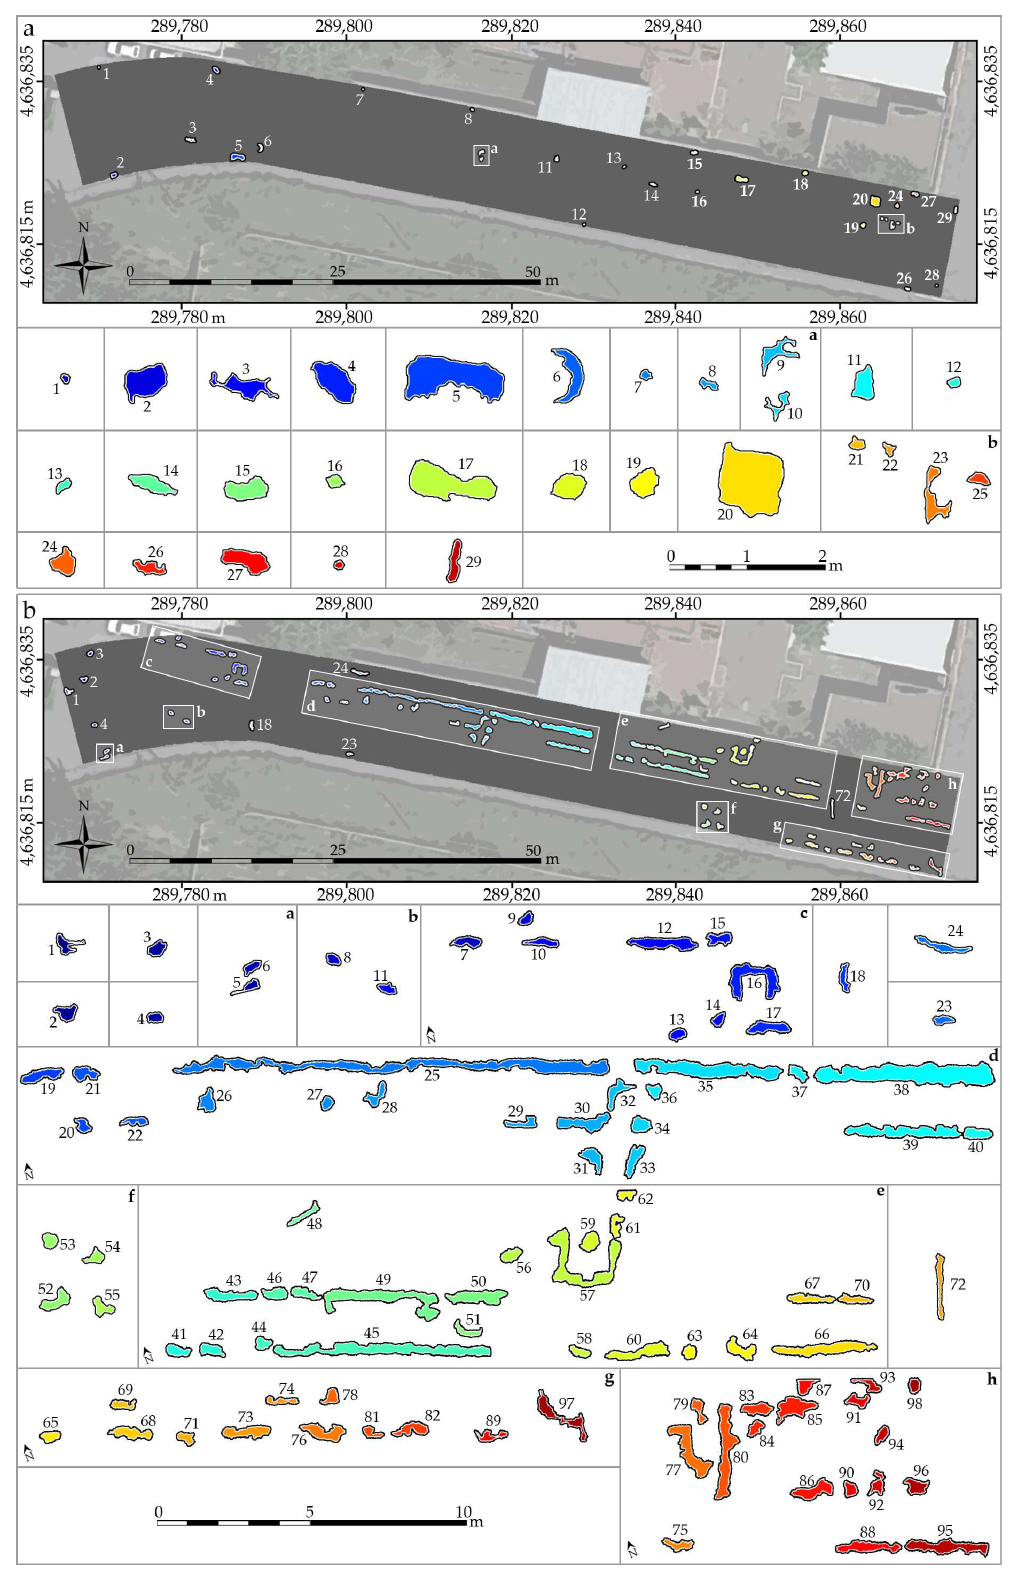
Figure 14. Distresses segmentation. (a) The potholes identified. (b) The swells/shoves identified.